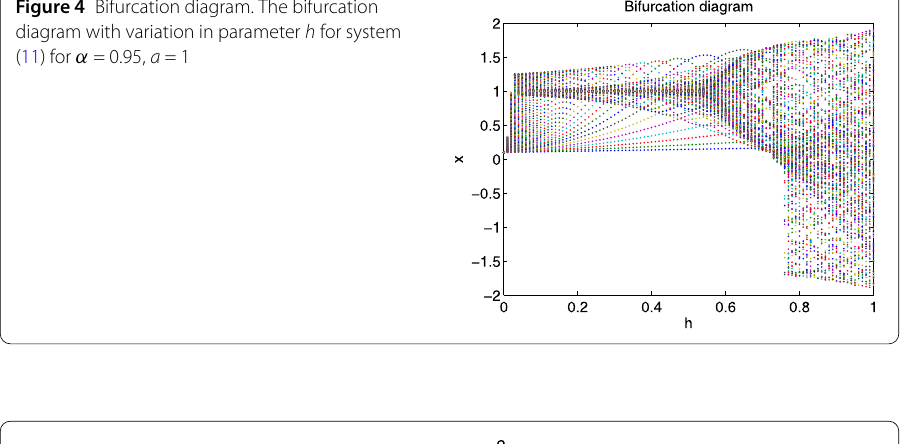
Figure 4 Bifurcation diagram. The bifurcation diagram with variation in parameter h for system (11) for α = 0.95, a = 1